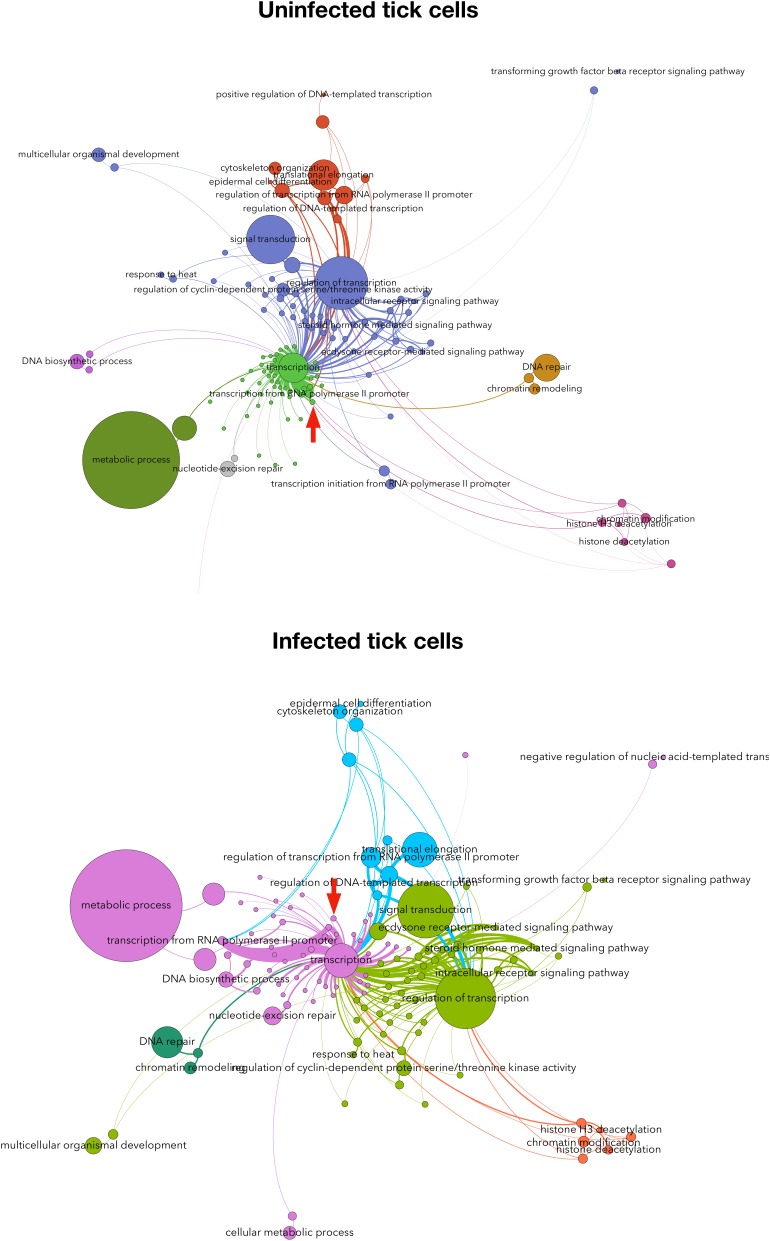
Subolesin regulome in tick cells. The network of proteins and processes associated to transcription in tick cells uninfected and infected with Anaplasma phagocytophilum. The nodes (circles) are either proteins or processes (labeled). The size of each circle is proportional to its centrality index. The networks show (clusters of interacting proteins and processes in colors. The width of each link is proportional to the strength of the interaction. The networks show the topology of the tick interactome and regulome. The networks were built with the annotated proteins represented in either uninfected or infected cells, and a directed network was built for each protein linked to the processes in which it is involved. The weight of each link is proportional to the number of reads of the protein. This weighted degree of each link was used to calculate the centrality indexes, mainly the Betweenness Centrality, which is represented in the panels. Only the proteins annotated as involved in processes associated with transcription (i.e., linked by one or more protein(s) simultaneously annotated as transcripiton or other cellular process). The topology of the networks was obtained with the Lovaine algorithm. In both networks, the topological position of Subolesin is marked with a red arrow. Methods were described in Estrada-Peña et al. (2018).)